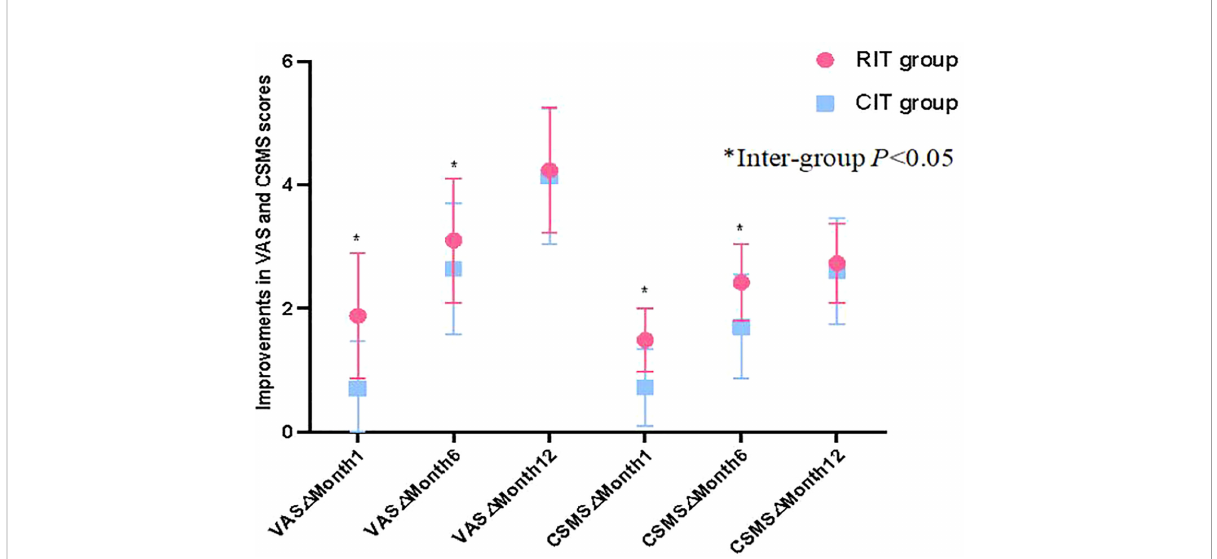
FIGURE 1 The comparision of clinical improvement. Patients in the RIT group had signi fi cantly greater VAS and CSMS improvements (reductions) from baseline than patients in the CIT group at months 1 and 6, although differences in VAS and CSMS improvement between the 2 groups became insigni fi cant at Month 12.